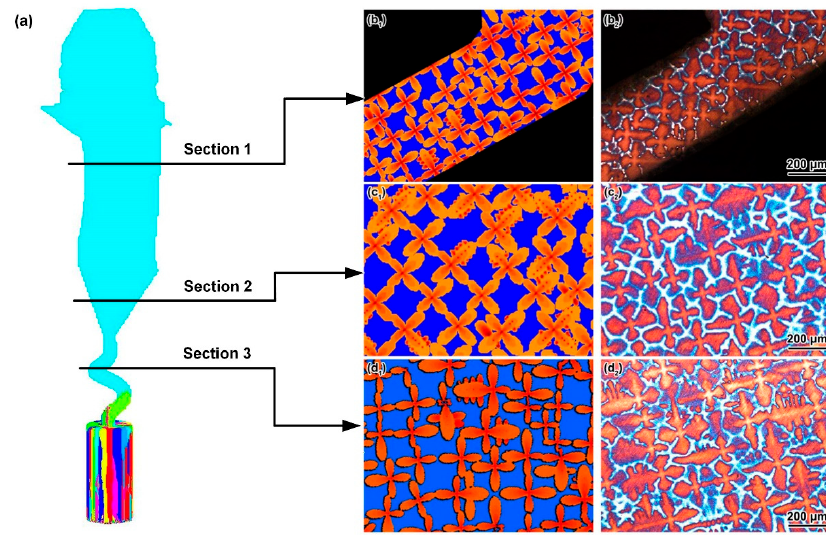
Figure 9. Simulation and experimental results of the grain and dendrite morphologies: ( a ) grain structure of the single crystal blade under HRS process; ( b1 , b2 ) dendrite morphology in the hollow part; ( c1 , c2 ) dendrite morphology in the lower part; and ( d1 , d2 ) dendrite morphology in the spiral selector